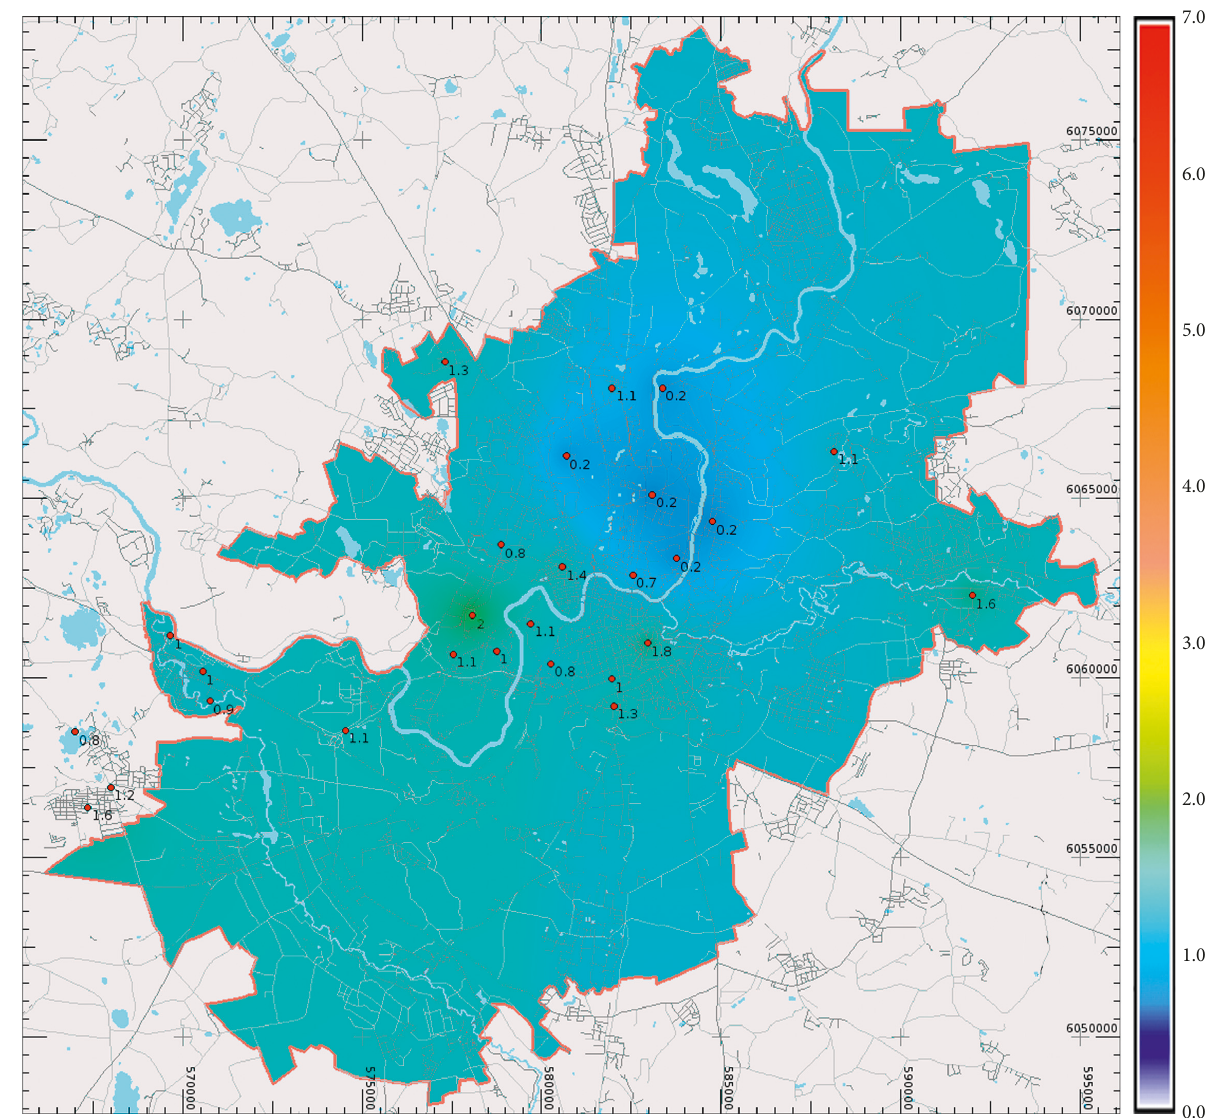
Figure 4: Annual mean concentrations of SO